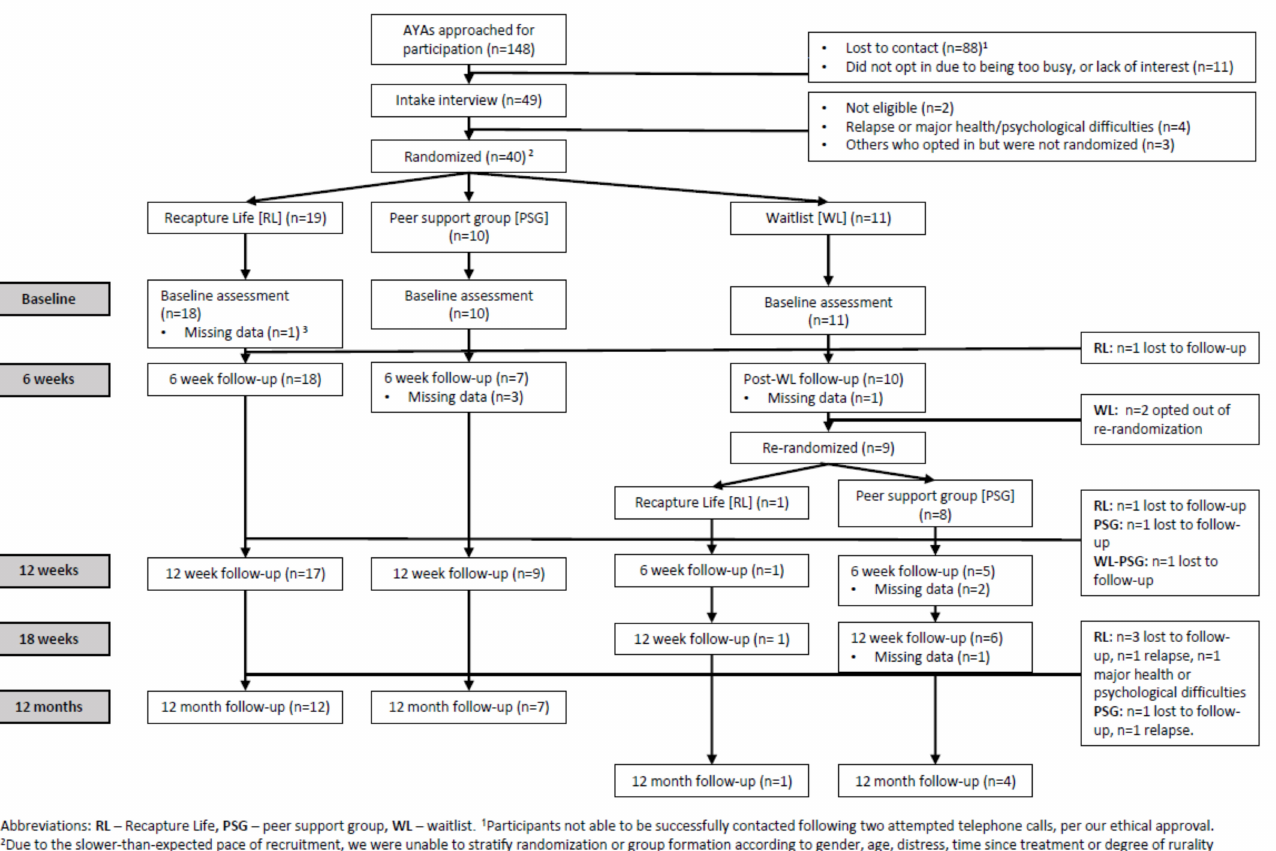
Figure 1. CONSORT flowchart depicting recruitment across Recapture Life